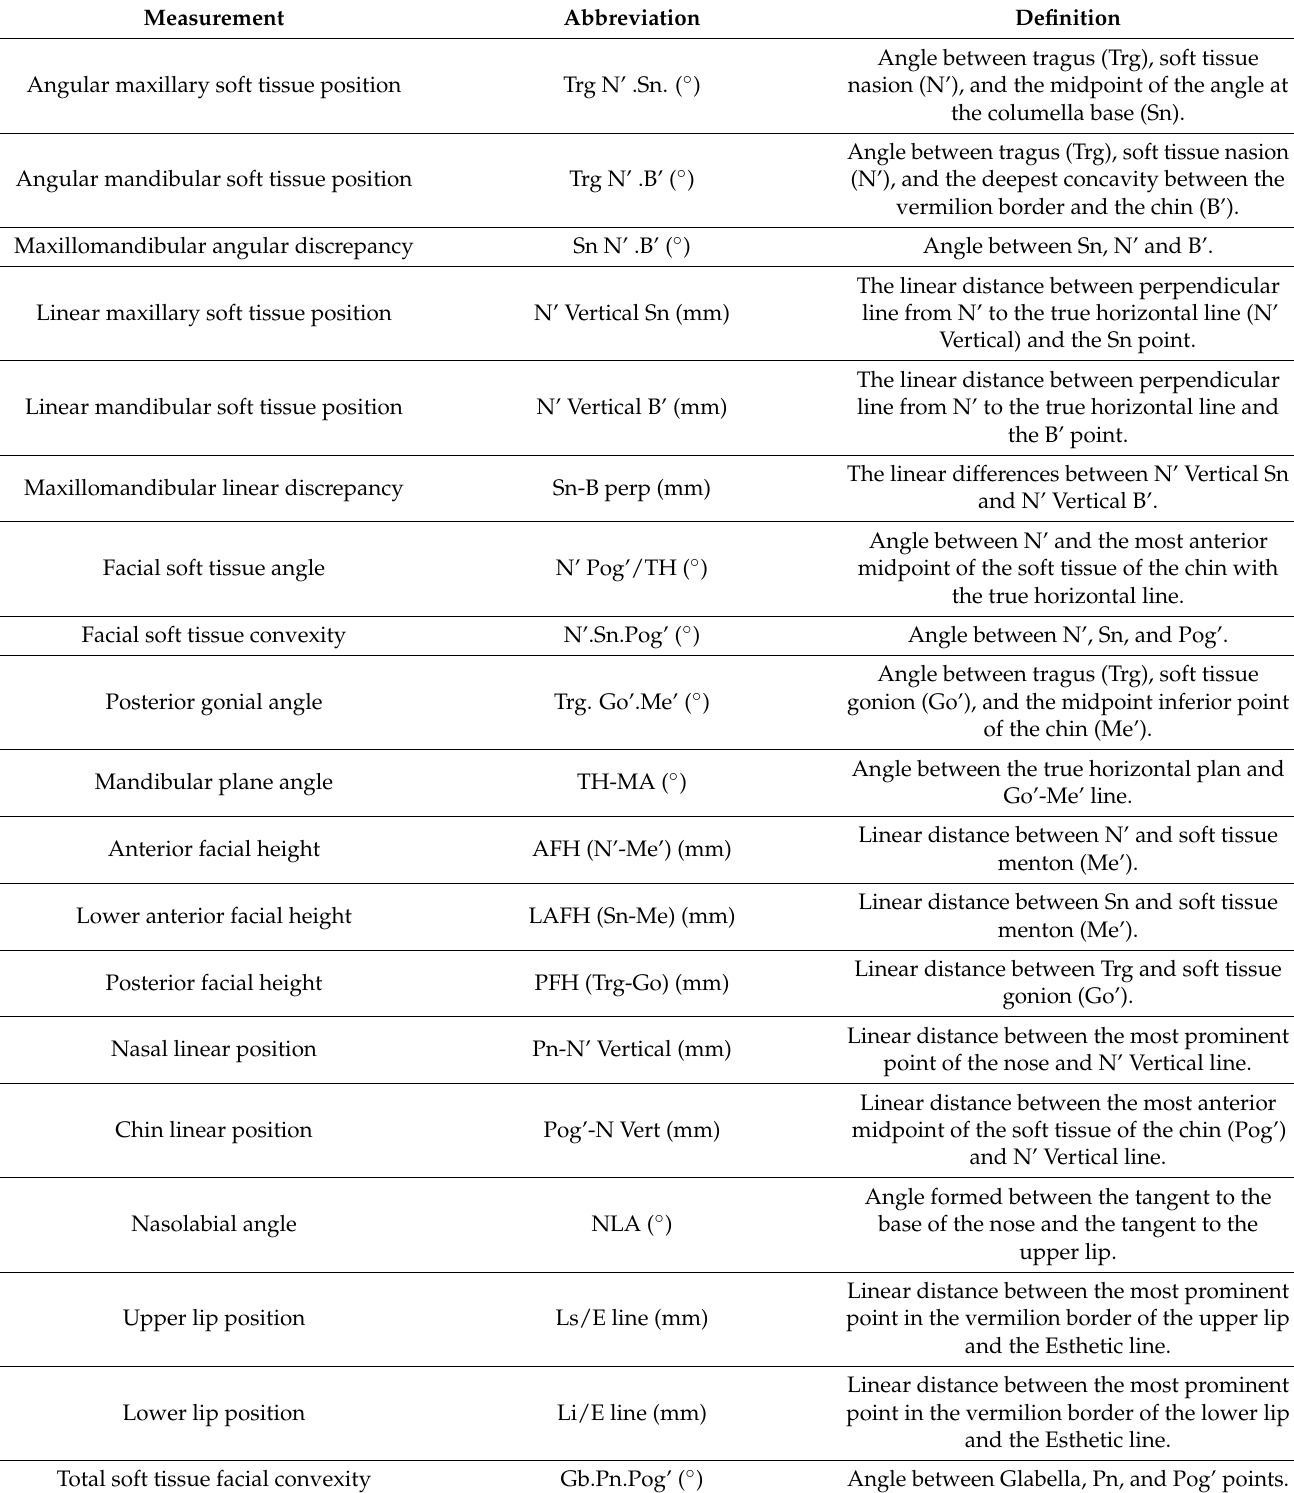
Table 1. Soft tissue measurements used in the